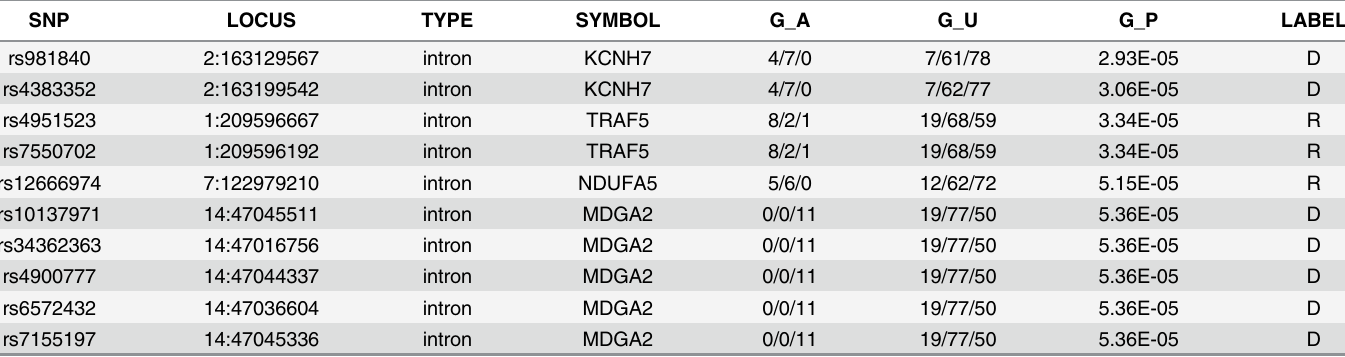
Table 3. Top 10 non-intergenic SNPs associated with susceptibility of CAA formation in KD using the general genotypic model. SNP LOCUS TYPE